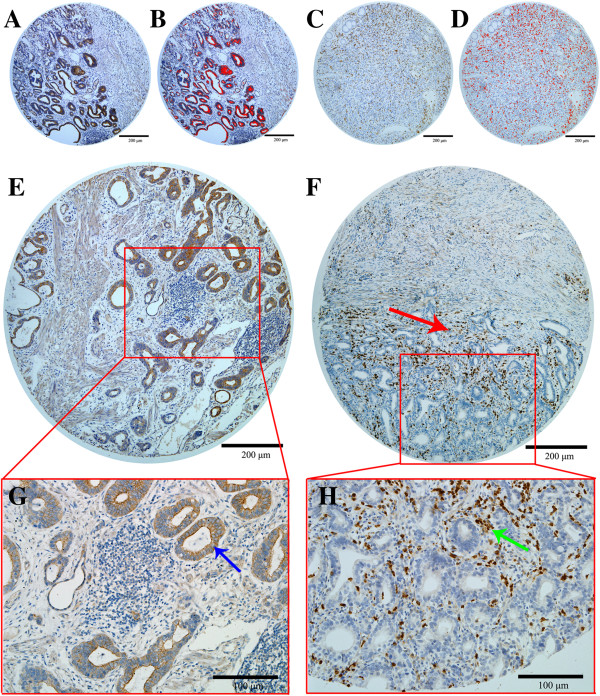
Immunohistological findings in TMAs. (A-D) Representative example of MT1-MMP (A), CD11b + immunocytes (C) staining of a GC tissue microarray, and the corresponding digital image analyzed with the image software, with MT1-MMP (B) and CD11b + immunocytes (D) represented in red. (E,G) MT1-MMP staining was mainly in the cytoplasm or on the cell membrane of tumor cells (Blue arrow), and most of the stroma cells had negative staining, although sporadic positive staining on these cells was also observed (F,H). CD11b staining showed that CD11b + immunocytes mainly infiltrated into the juncture of cancer nest and stroma, especially at the invasive front (Red and Green arrows).